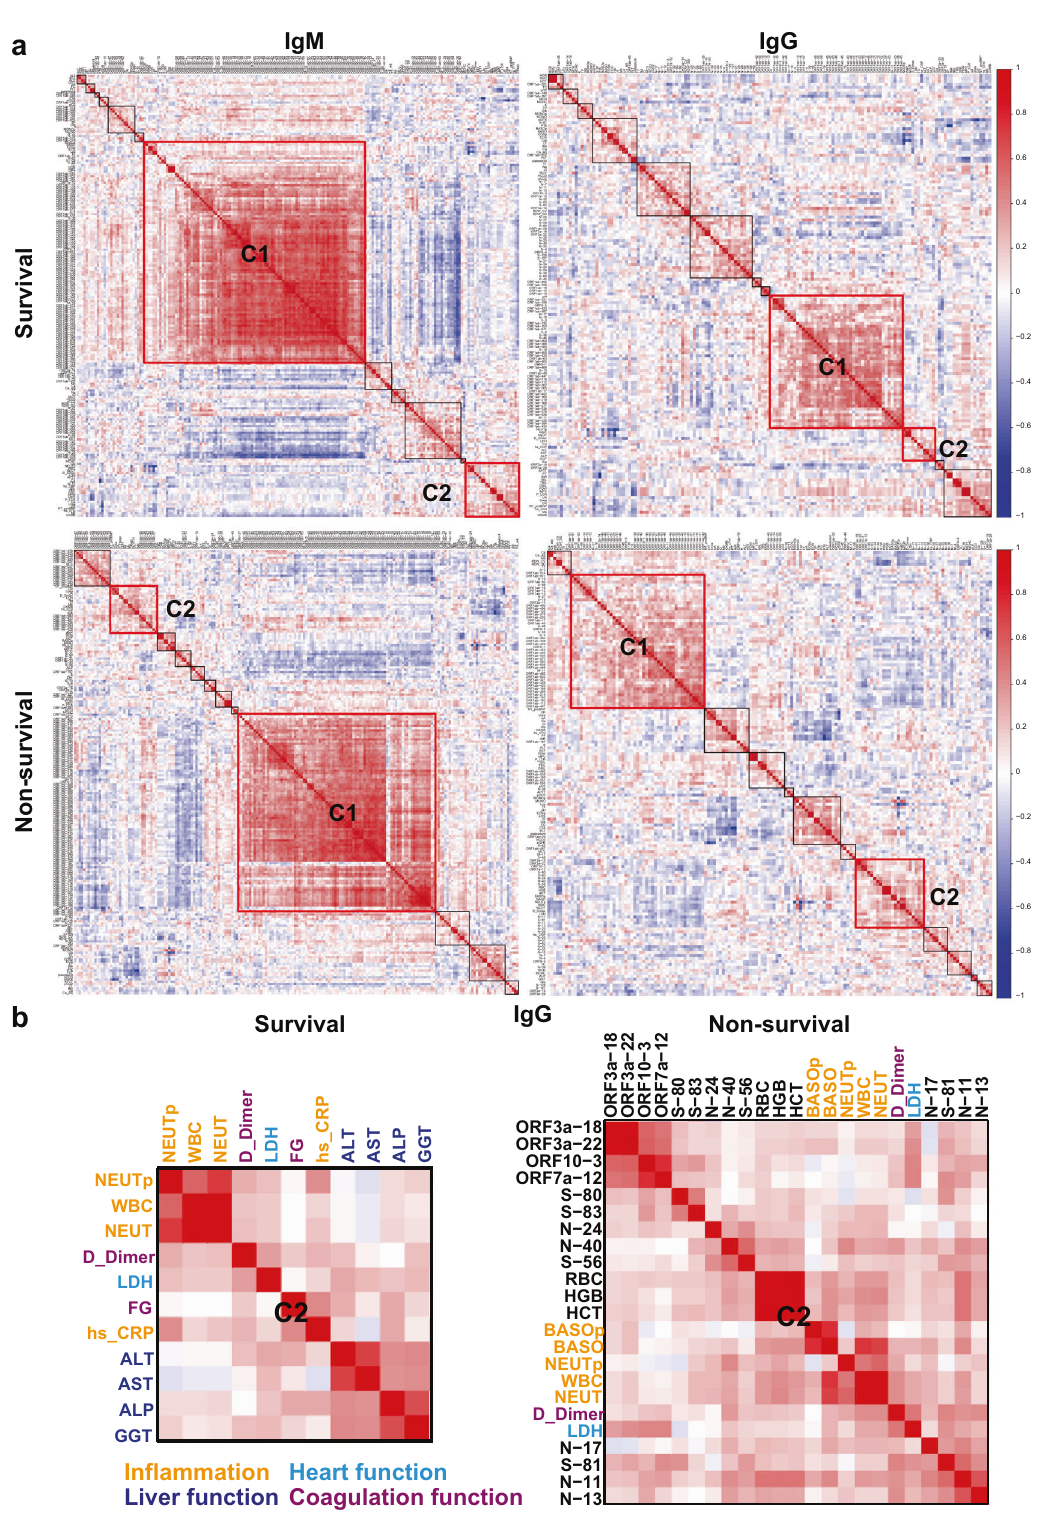
Fig. 8 Correlations between antibodies to structural proteins and clinical variables associated with COVID-19 survival. a Global correlation map of the SARS-CoV-2 proteome IgG antibodies and clinical variables in the survival and non-survival COVID-19 patient groups. b Differential correlations of the clinical variables and SARS-CoV-2 IgG antibodies between survival and non-survival COVID-19 groups in the cluster #2 group. The rainbow color from blue to red corresponds to the correlation of two variables from − 1 (low correlation; blue) to + 1 (high correlation;